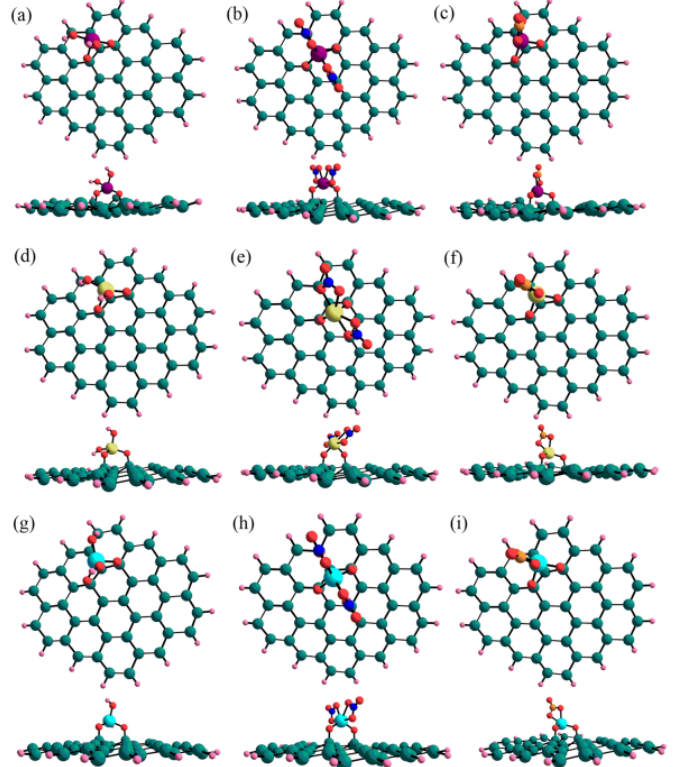
Figure 9. Top and side views of the optimized solvated structures in water for ( a ) [UO 2 (OH) 2 ], ( b ) [UO 2 (NO 3 ) 2 ], ( c ) [UO 2 (CO 3 )], ( d ) [NpO 2 (OH) 2 ], ( e ) [NpO 2 (NO 3 ) 2 ], ( f ) [NpO 2 (CO 3 )], ( g ) [PuO 2 (OH) 2 ], ( h ) [PuO 2 (NO 3 ) 2 ], and ( i ) [PuO 2 (CO 3 )] on the Si 42 H 16 flake. Purple means U, light green is Np, light blue is Pu, red is O, dark blue is N, orange is C, turquoise is Si and pink is H. Reprinted with permission from ref. [51]. Copyright 2021 Amrican Chemical Society.